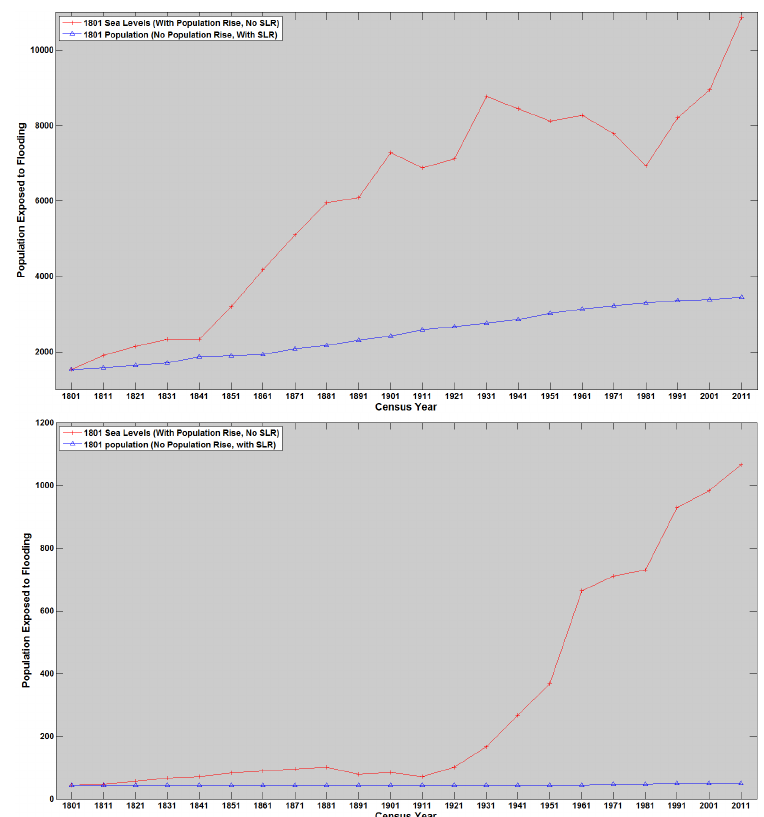
Figure 9. Estimated number of people exposed to flooding (1 in 200 year recurrence interval, no defences) in Portsea (above) and Hayling (below) for no change in sea levels since 1801 (red line) and no change in population since 1801 (blue